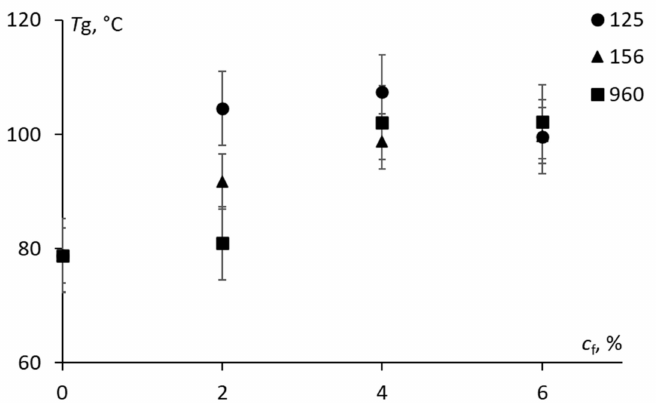
Figure 4. The glass transition temperature of the epoxy modified with different additives containing CSR nanoparticles (indicated on the graph) as a function of filler weight fraction.